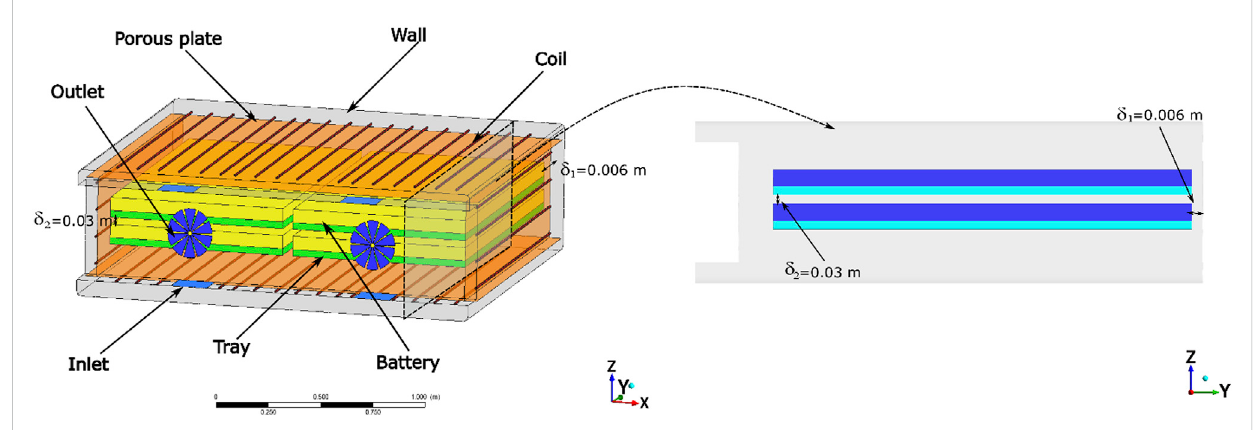
FIGURE 2 Illustration of the boundary condition or load condition applied in the model.